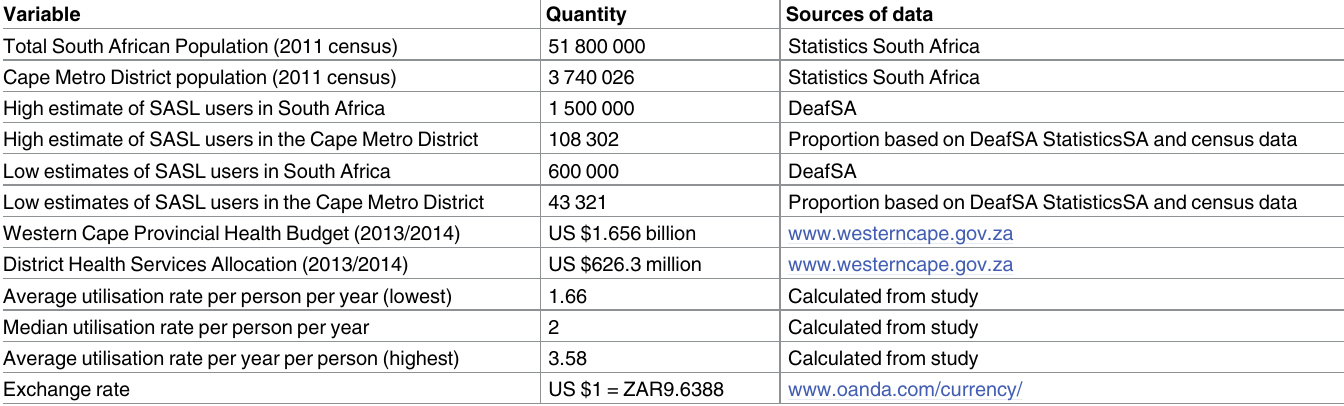
Table 1. Parameters used for the calculation of the costs of scaling